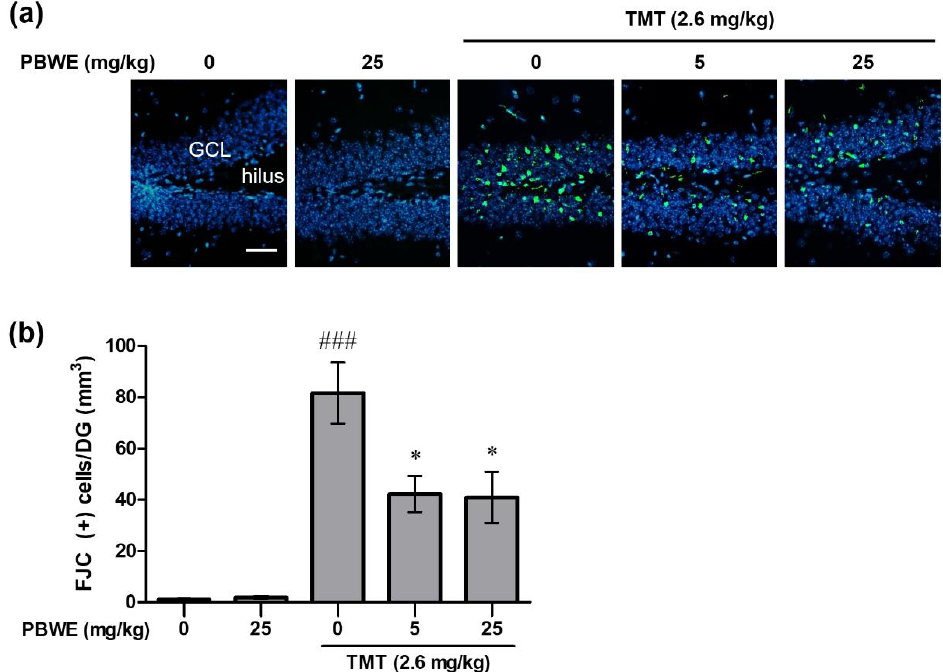
Figure 4. Protective effect of the Protaetia brevitarsis seulensis’ water extract (PBWE) on the number of Fluoro-Jade C (FJC)- positive degenerating neurons in the dentate gyrus (DG) of hippocampus on day 4 post-trimethyltin (TMT)-treatment. ( a ) Representative images (200 × ) show degenerating FJC-stained cells (green color) in the saline-treated control, TMT-treated control, and PBWE-pretreated TMT groups. ( b ) Graph depicts the number of FJC-positive cells per DG, in the hippocampus sections ( n = 4 in each group). Values are reported as mean ± SE. ### p < 0.001 vs. saline-treated group, * p < 0.05 vs. TMT alone-treated group. Scale bar represents 40 μm. GCL, granular cell layer.